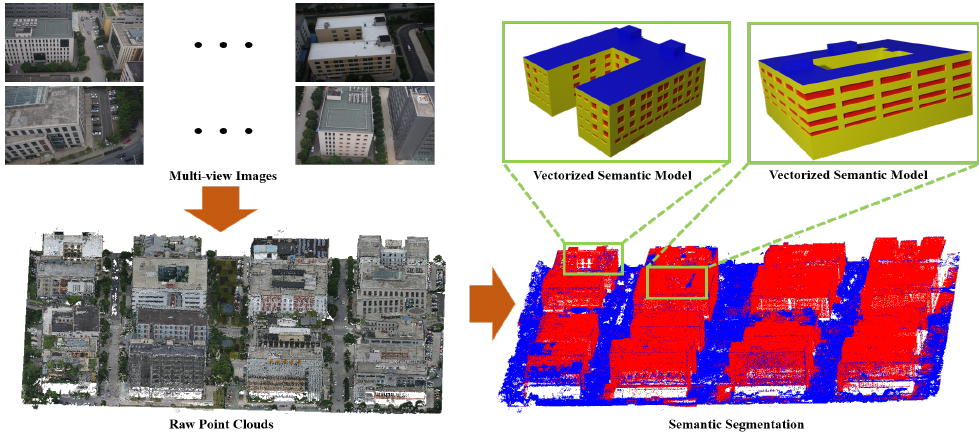
Figure 5. Dataset I, large urban area, used in our experiments. The urban scene of Dataset I, which includes 52 million points were reconstructed from 1705 images collected by unmanned aerial vehicle. The original multi-view images are shown in the top left of the image. We can reconstruct and segment the scene point cloud in the bottom left with multi-view images. The point cloud semantic segmentation results generated by our algorithm are shown in the bottom right of the image. After extracting the building point clouds, the building models can be optimized and vectorized. The produced vectorized semantic models are shown in the top right.